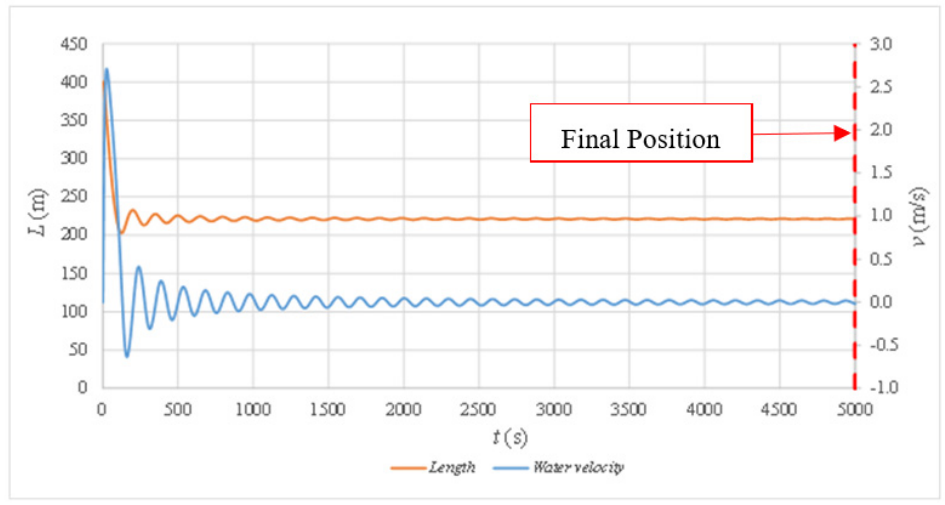
Figure 3. Evolution of length and water velocity for the case study.